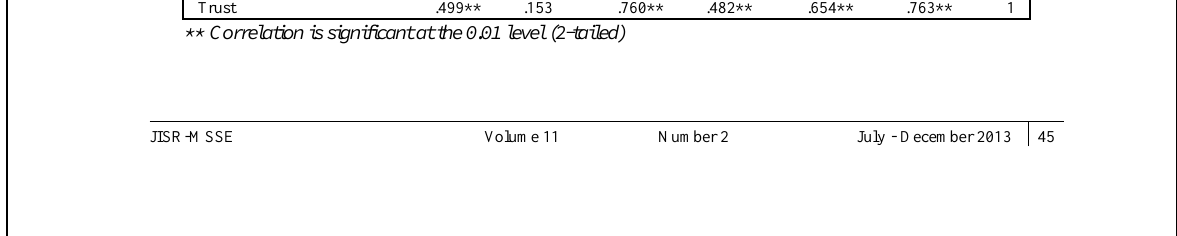
** Correlation is significant at the 0.01 level